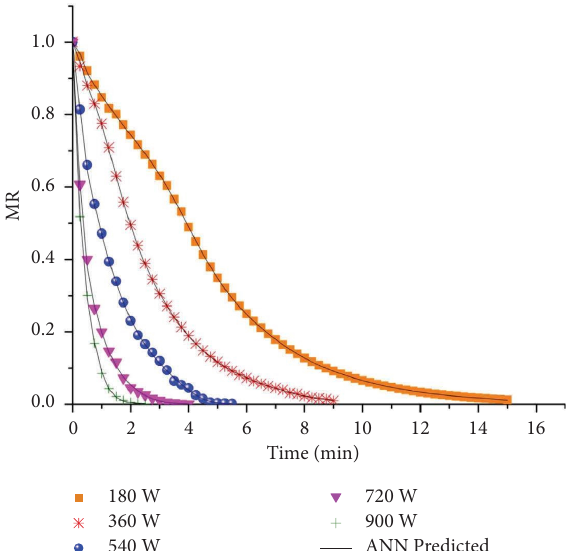
Figure 6: Best ANN model prediction and experimental data for microwave drying of Stevia